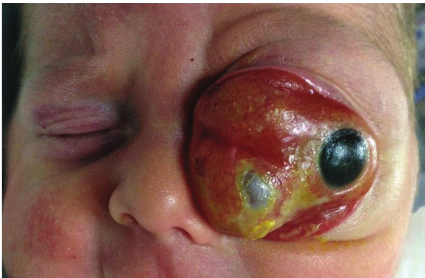
Figure 1: Preoperative clinical photography shows the significant proptosis and anterolateral displacement of left eye.